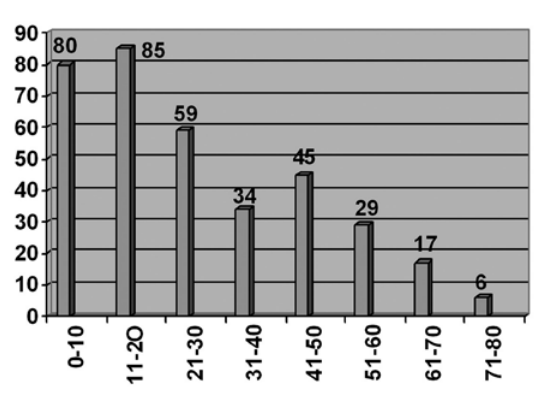
Figure 1. Dog bite injuries distribution related to the age group